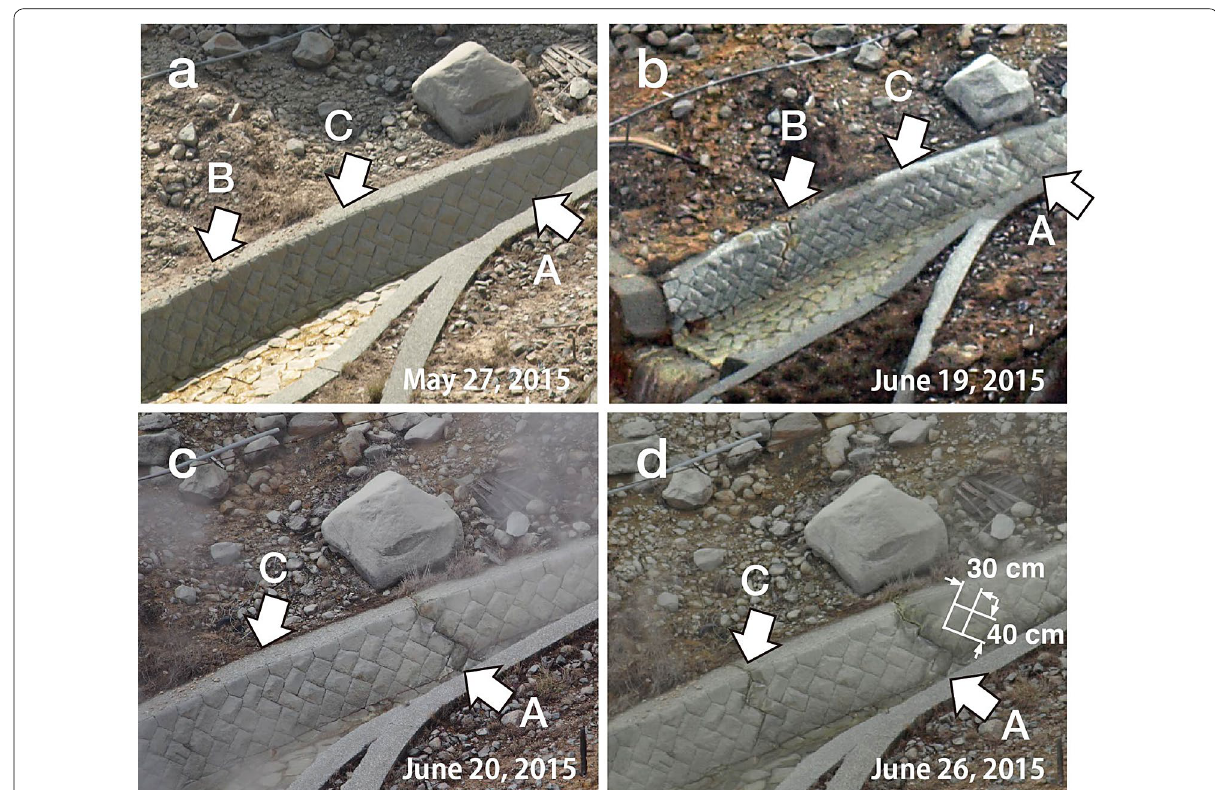
Fig. 9 Cracks appeared on a training wall near the no. 39 SPW in Owakudani. White arrows indicate the positions where cracks were formed. a On May 27, no apparent cracks had formed. b Three weeks later, cracks A and B with sulfur and ferrioxide at the opening had formed. c From crack A, water seems to be seeping out but the place where crack C will be formed seems intact. d A week later, crack C is newly formed. The size of the stone blocks paving the wall is 40 cm 30 cm. The location of these cracks is shown in Fig. 2. All photographs are taken by ×